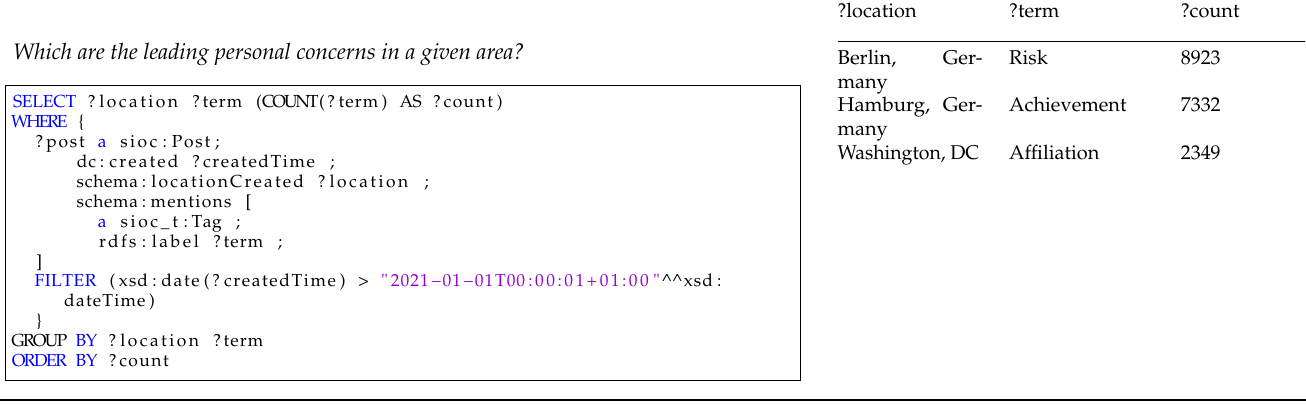
Table 5. Competency